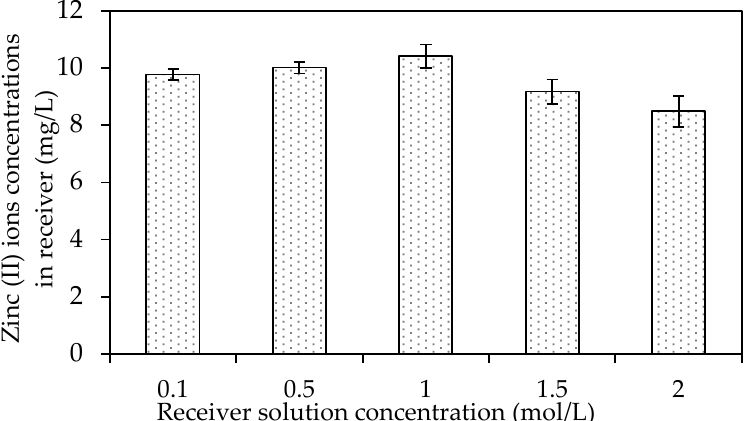
Figure 14. The effects of different receiver solution concentrations on the concentration of Zn 2+ in the receiving phase.